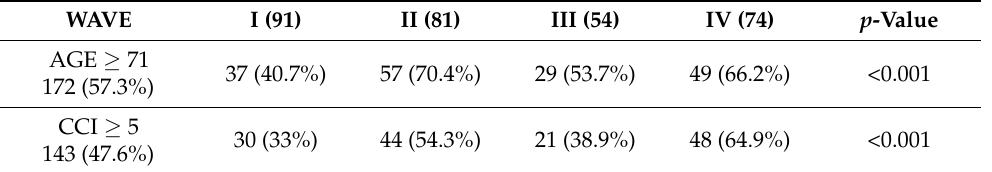
Table 2. In-hospital mortality stratified by age and CCI: comparison of